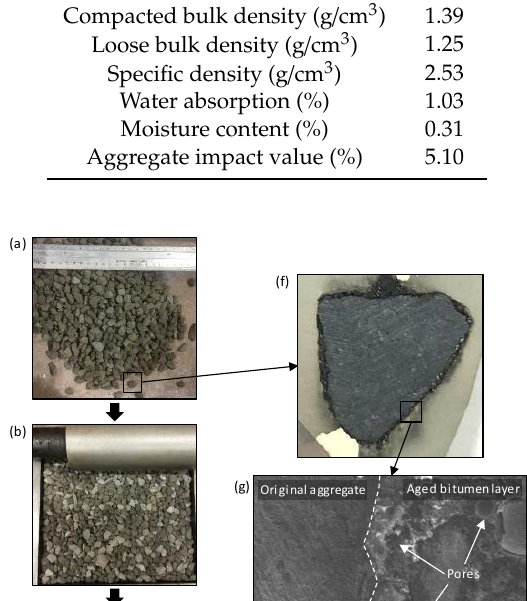
Table 1. Properties of RAP aggregate.